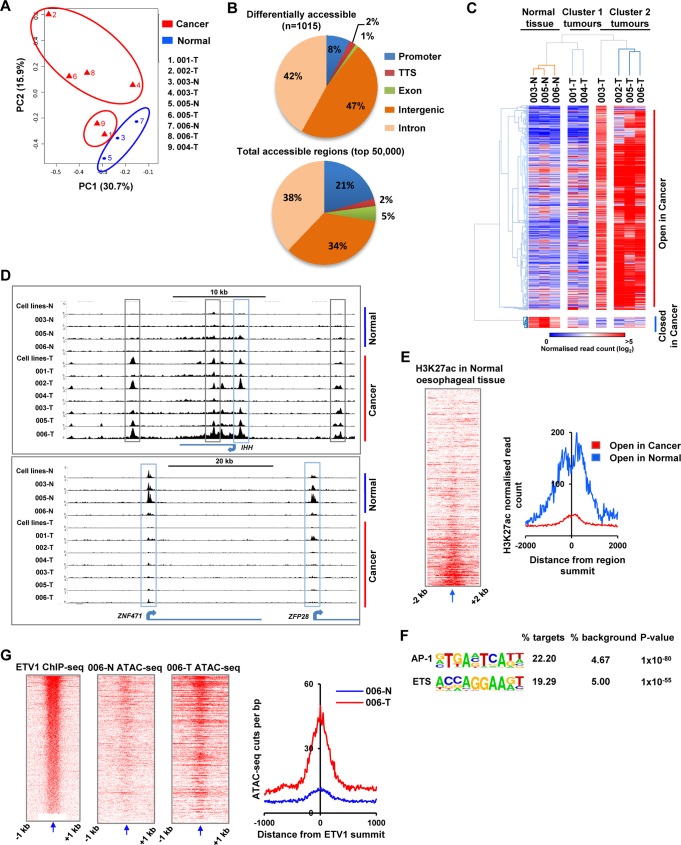
ATAC-seq reveals in patient samples identifies AP1 and ETS proteins as regulators of OAC.(A) PCA analysis of the 9 tissue samples across the top 50,000 accessibility regions derived from merging reads from all samples and recalling peaks using MACS2. Tumour samples are shown in red and normal samples in blue. (B) Pie chart showing the genomic distribution of the top 50,000 accessible regions across all tissue samples (bottom) or the 1015 differentially more accessible regions (top) in OAC cancer samples (promoter = +/- 1 kb from TSS). (C) Heatmap of normalised Tn5 cleavage events (log2) in 500 bp windows at the regions showing significant differential accessibility between normal and tumour tissue samples (+/- linear fivefold change, P<0.05). Data are subjected to hierarchical clustering using 1-Pearson’s correlation. (D) UCSC browser track showing open chromatin regions at the IHH, ZNF471 and ZFP28 loci in the indicated patient-derived normal and tumour tissue samples. Intergenic and intragenic (grey boxes) and promoter proximal (blue boxes) peaks are highlighted. Aggregated data from either two normal (-N) or three OAC (-T) cell lines is also shown. (E) Heatmap (left) and average tag profile (right) of normalised H3K27ac ChIP-seq tag density (GSM1013127) in normal oesophageal tissue (shown in a +/- 2 kb region around summit of each differentially accessible peak). Average profiles are shown for regions that are either more open in cancer (red line) or more open in normal (blue line) samples. (F) AP-1 and ETS motifs identified via de novo motif discovery, at regions that are more open in cancer (n = 962) against CpG matched background. (G) Heatmaps (left) and average ATAC-seq cleavage events (right) of ATAC-seq tag density in normal (blue line) and tumour (red line) samples from patient 006. Data are shown in a +/- 1 kb region relative to the summit of the ETV1 binding peaks defined by ChIP-seq in OE33 cells. Regions in the heatmaps are ranked according to ETV1 ChIP-seq signal (shown on the left).